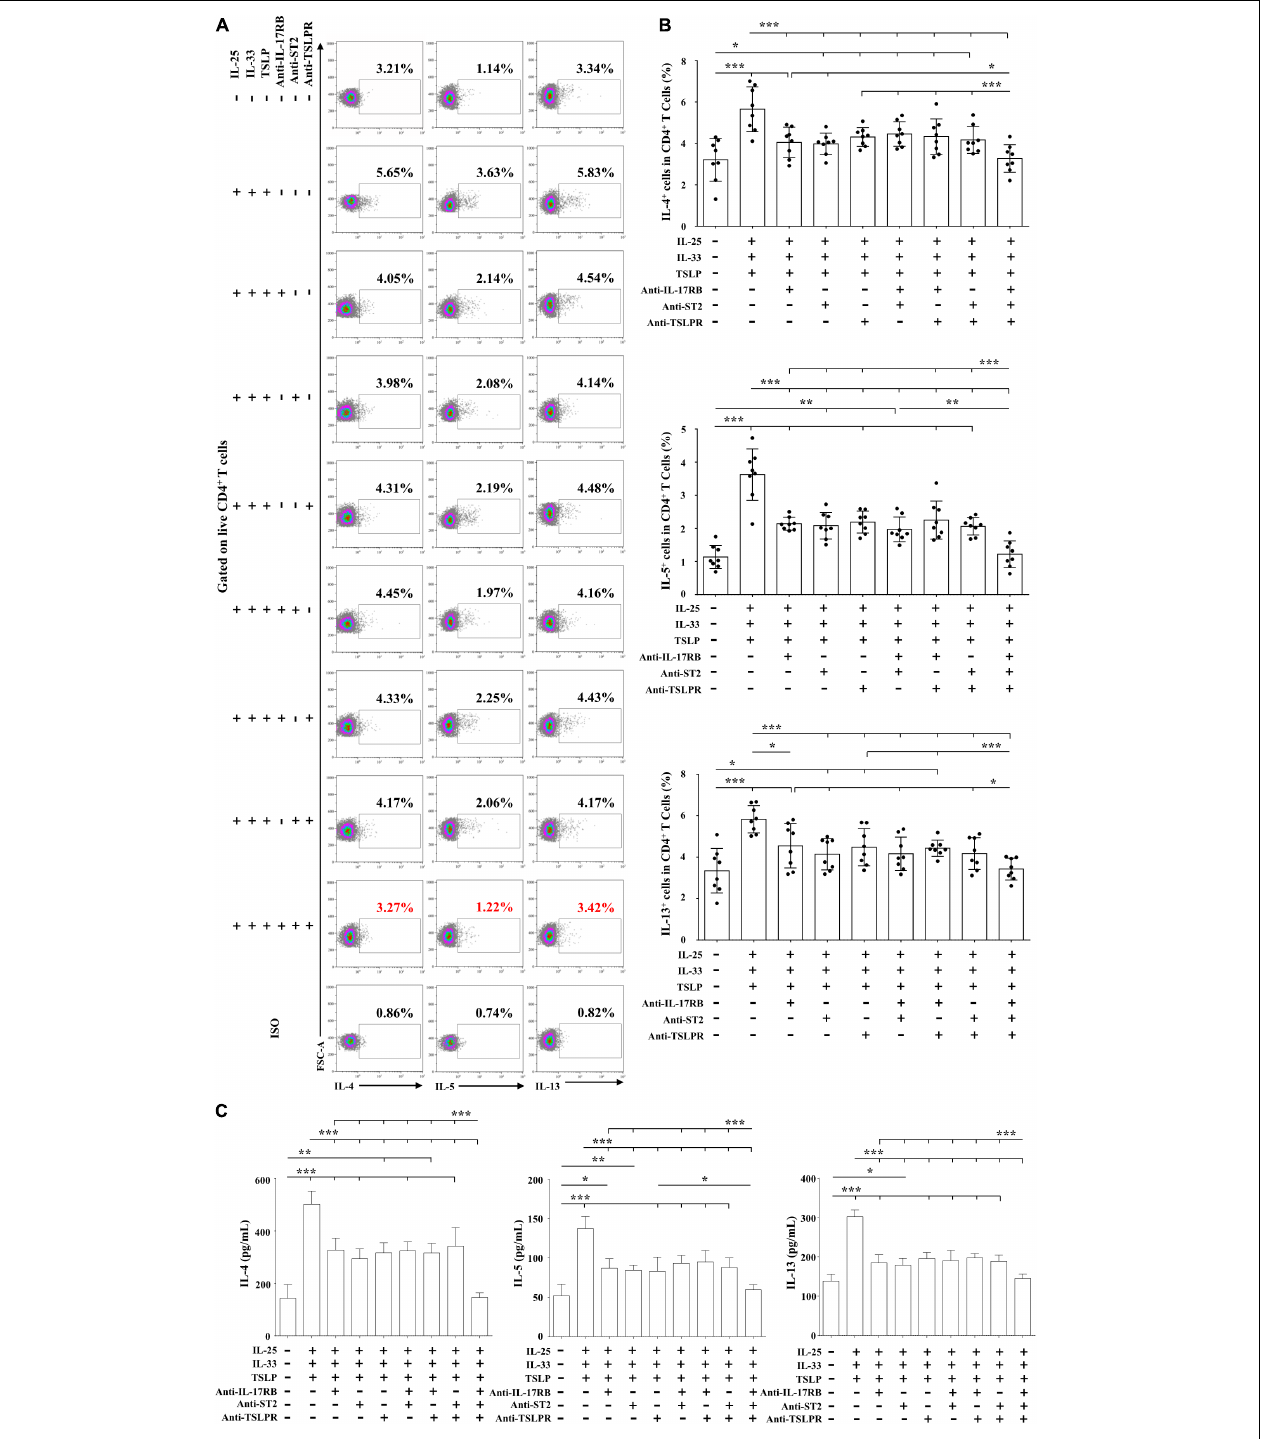
FIGURE 7 | Combined pro-Th2 effects of IL-25, IL-33, and TSLP on AR-derived mo-DCs. (A) Representative flow plots of IL-4, IL-5, and IL-13 expression by CD4 + T cells co-cultured for 5 days with Der.p1-induced mo-DCs from AR subjects ( n = 8). Prior to co-culture, mo-DCs were induced by Der.p1 in the presence of anti-IL-17RB, anti-ST2, and anti-TSLPR blocking antibodies, singly or in combination, for 48 h, and then further stimulated with combined IL-25, IL-33, and TSLP for 24 h. (B) Quantification of percentages of IL-4 + , IL-5 + , and IL-13 + cells in CD4 + T cells. (C) Protein levels of IL-4, IL-5, and IL-13 in the supernatants of co-cultured cells, as measured by ELISA ( n = 6). Data are expressed as means ± SD. Significant differences were tested using the paired t -test between control and antibody blocking groups, and using Student’s t -test between antibody blocking groups. * P < 0.05, ** P < 0.01, *** P < 0.001.